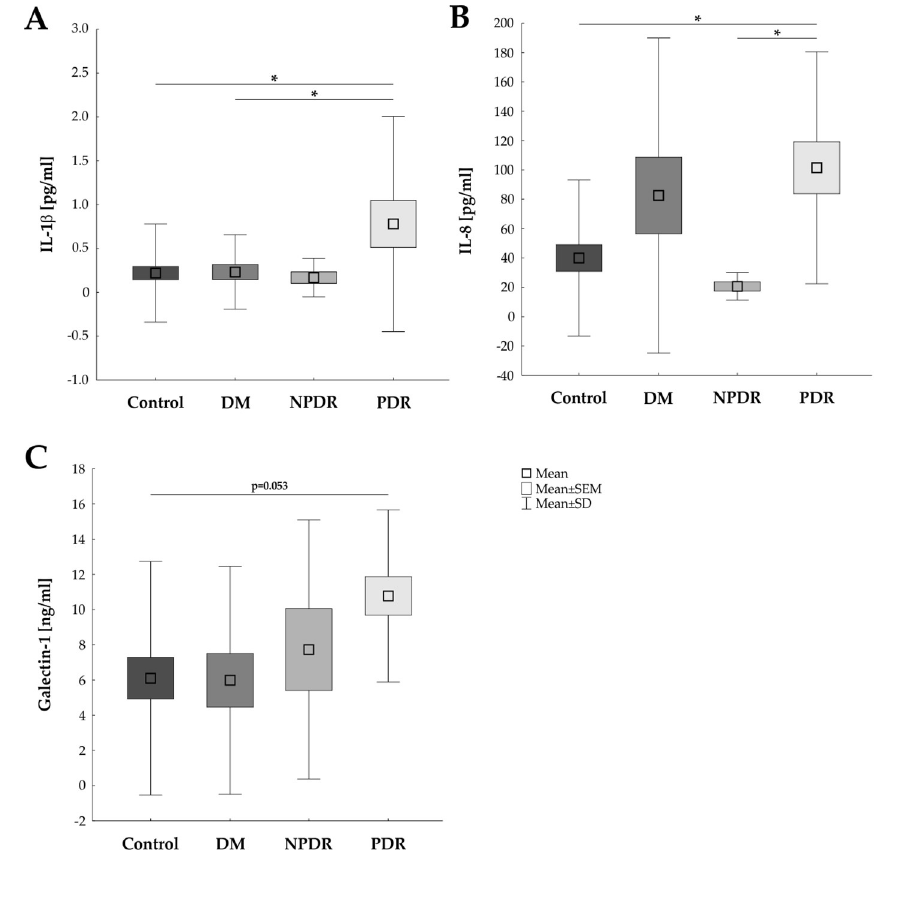
Fig 2. Increased pro-inflammatory cytokine expression in PDR. A) An increased IL-1 β expression level was noted in PDR vitreous in contrast to control (p = 0.012) and DM (p = 0.043) samples. B) In addition, the IL-8 concentration was significantly higher in PDR patients than in control (p = 0.018) and NPDR patients (p = 0.034). C) Galectin-1 displayed a trend towards an up-regulation in PDR samples when compared to control samples (p = 0.053). DM: diabetes mellitus; NPDR: non-proliferative diabetic retinopathy; PDR: proliferative diabetic retinopathy; values are mean ± SEM ± SD; � p < 0.05.